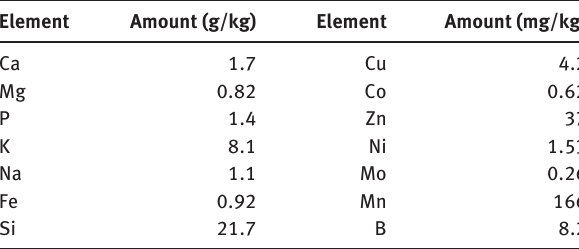
Table 3 Inorganic contents of dry water reed [6,